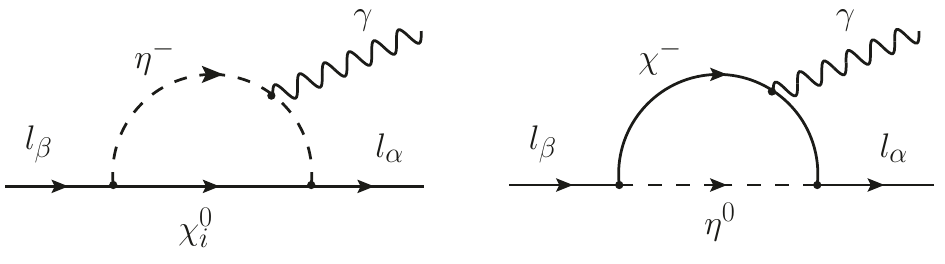
Figure 5 . Dominant Feynman diagrams in the l (cid:12)